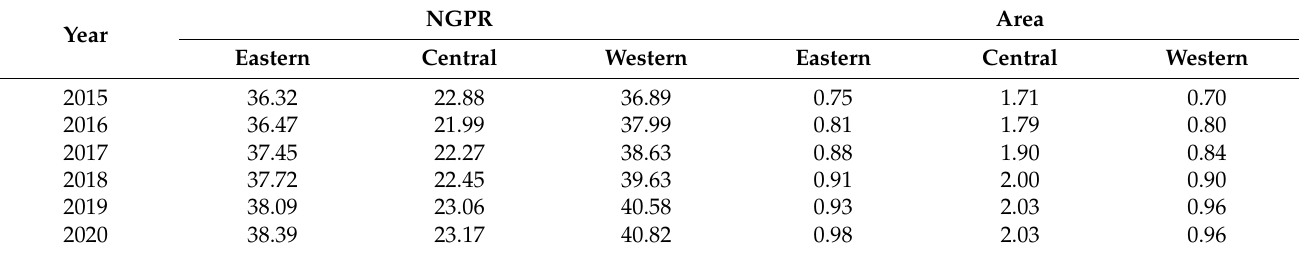
Table 3. Trend changes of NGPR and area by year and